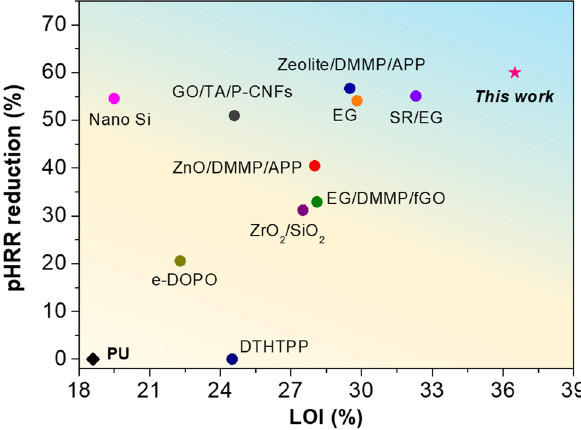
Fig. 6 Flame retardancy comparison (pHRR reduction and LOI value) of as‑prepared FRPU with other previously reported flame‑ retardant PU foam material